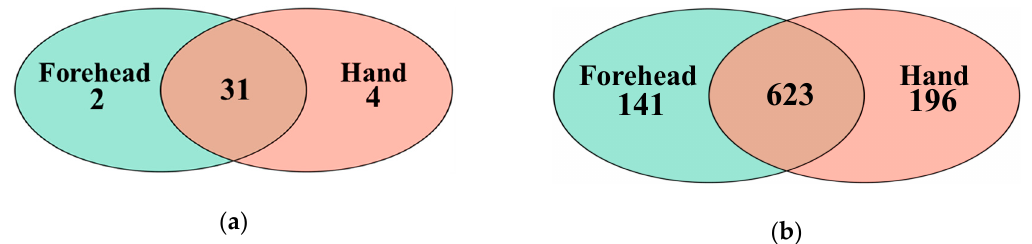
Figure 2. Shared taxa at the phylum and genus levels shown in a Venn diagram. ( a ) A total of 31 phyla were shared between the forehead and hand groups, ( b ) 623 genera were shared between the forehead and hand groups. Table 4. Alpha-diversity measurements by age groups.